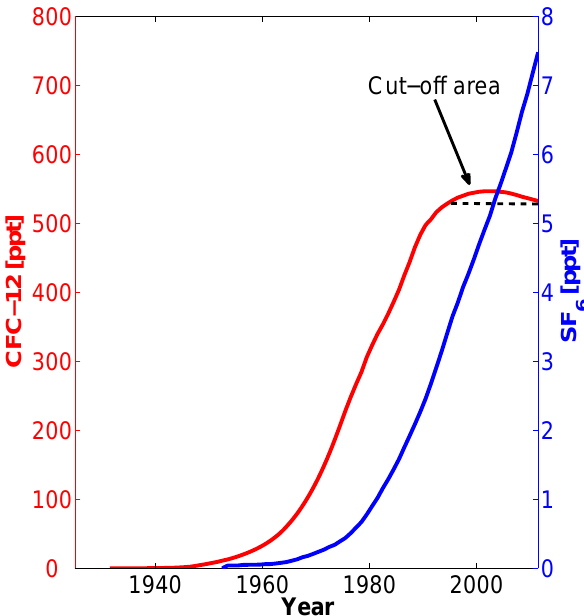
Figure 2. Atmospheric histories of CFC-12 (red) and of SF 6 (blue). The decreasing trend of CFC-12 produces a cut-off area between 1994 and 2011, which means that any CFC-12 concentration above 532ppt provides only inconclusive information about ventilation.